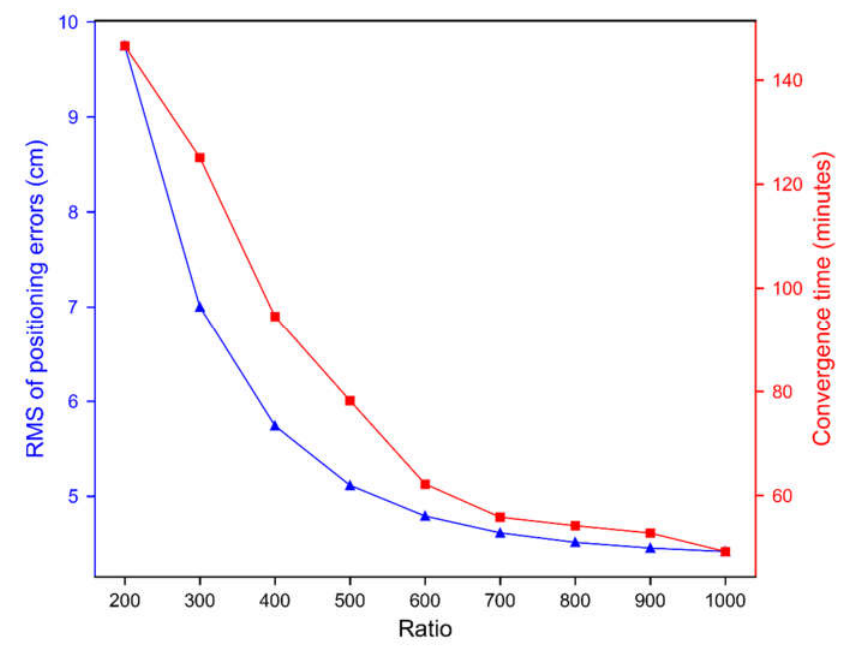
Figure 10. Comparison of positioning accuracy and convergence time with different ratio values on DOY 031.